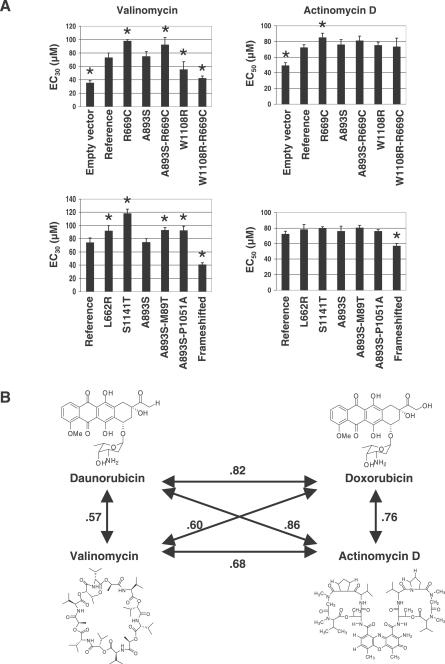
Comparison of Resistance of the P-Gp Variants to Different Drug Substrates(A) Alterations in resistance of P-gp variants to valinomycin and actinomycin D. The degree of resistance of the variants to valinomycin and actinomycin D are presented as EC30 and EC50 values, respectively. Each EC30 or EC50 value represents the average ± standard deviation of three measurements. The values with significant differences (p < 0.05) are marked with *.(B) Correlation of the drug resistance profiles for different drug substrates. The correlation coefficients for each pair of EC50 (or EC30) values are presented.